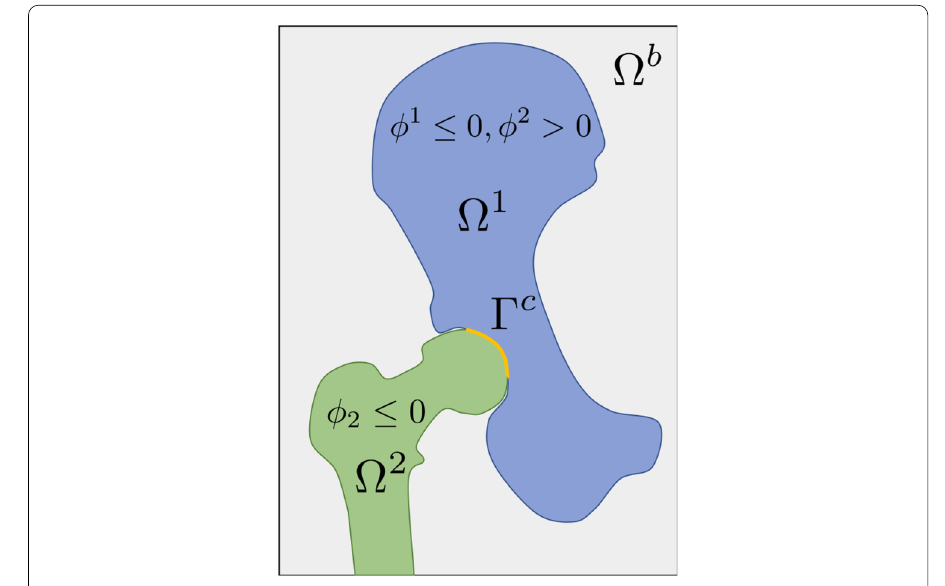
Fig. 1 Contact problem between two domains (cid:2) 1 and (cid:2) 2 described -via two level set functions φ 1 and φ 2 and contact interface (cid:4) c embedded in background domain (cid:2)